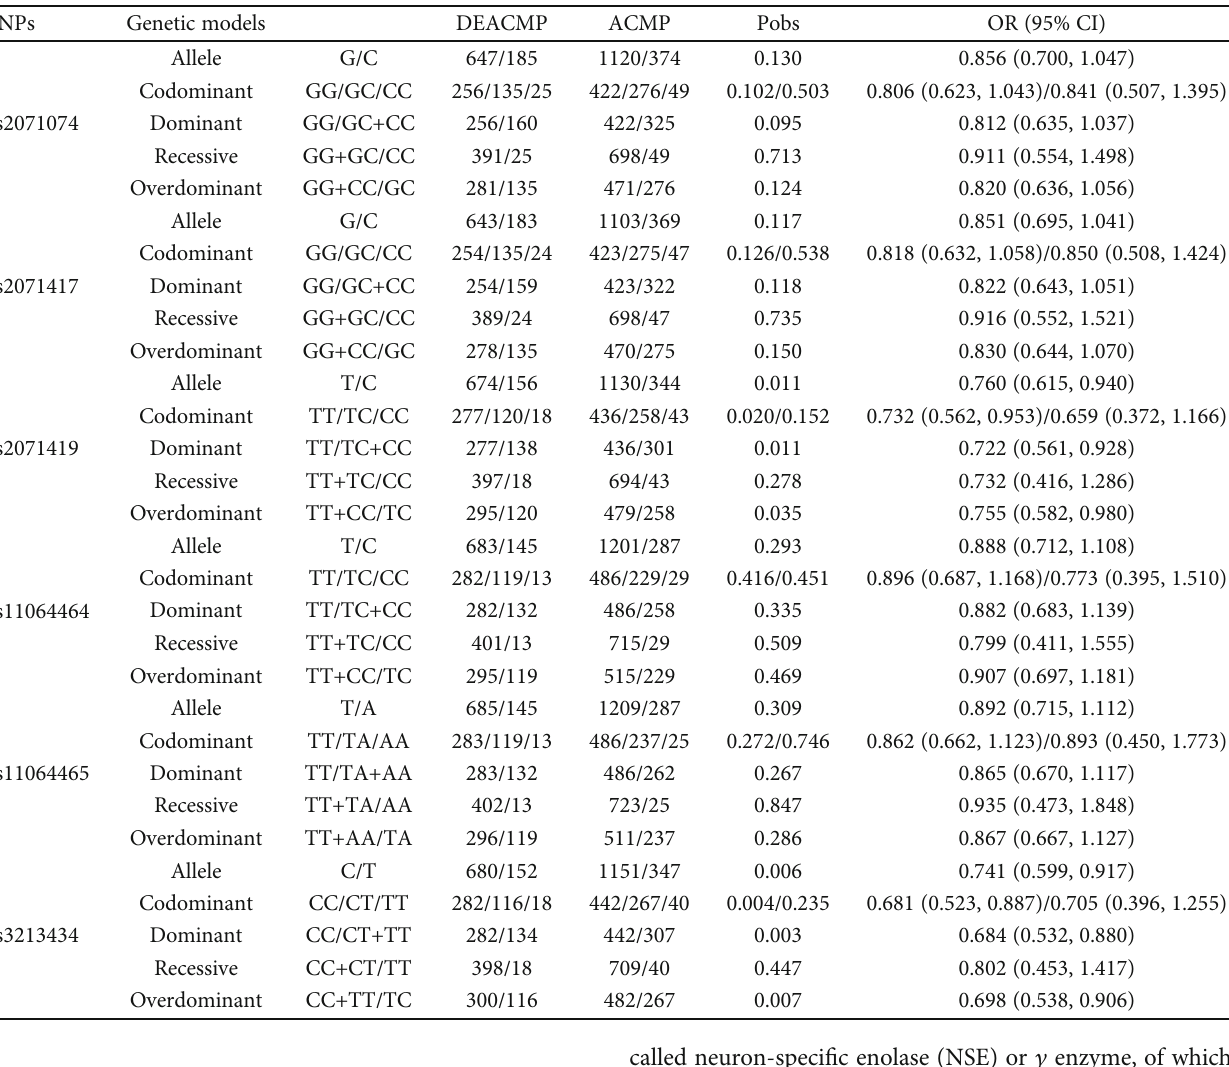
Table 4: Correlation analysis of NSE polymorphisms under di ff erent genetic models and DEACMP risk.